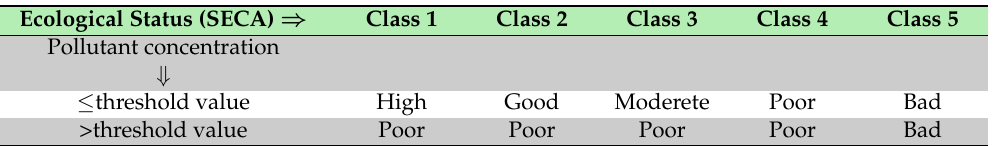
Table A3. Determination of environmental status according to the sulphur-emission control area (SECA) class and the concentration of additional